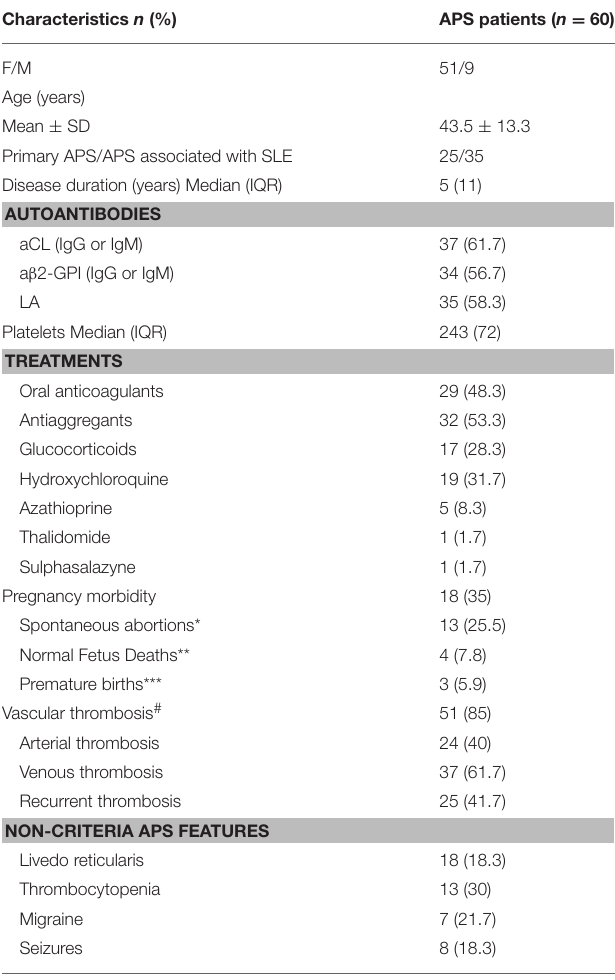
TABLE 1 | Clinical characteristics of patients studied. Characteristics n